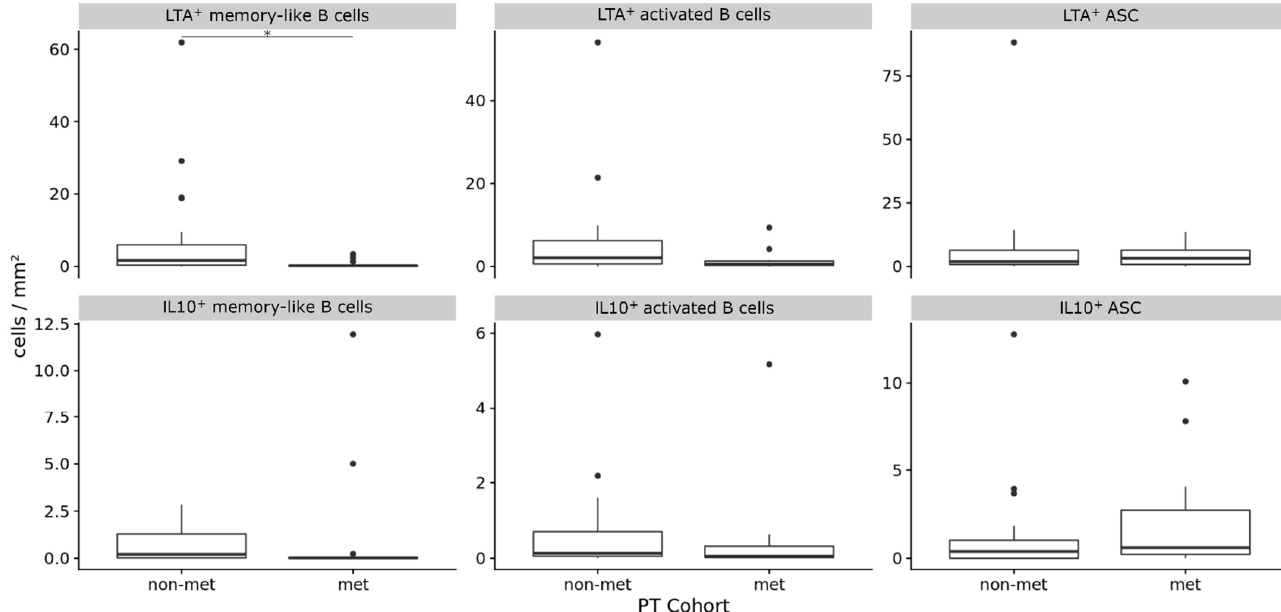
Figure 2. The frequencies (cells/mm 2 ) of LTA + and IL-10 + B cell subpopulations in primary human melanomas and their association with metastasis. Box plots comparing primary tumors that did not metastasize (non-met) versus those that metastasized (met). In boxplots, lower and upper hinges correspond to the first and third quartiles and center lines to medians. Lower and upper whiskers extend from the hinge to the largest value within 1.5 times the interquartile range. Outliers are shown as black circles, * p ≤ 0.05. ASC = antibody secreting cells.